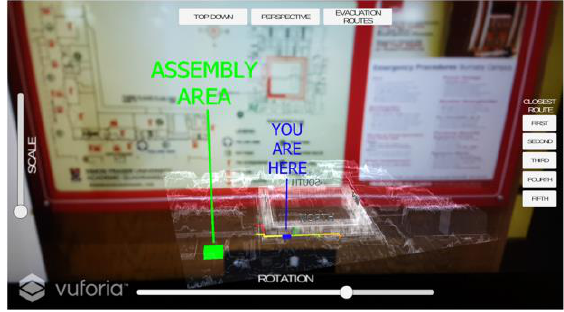
Figure 8. Spatially contextualized evacuation